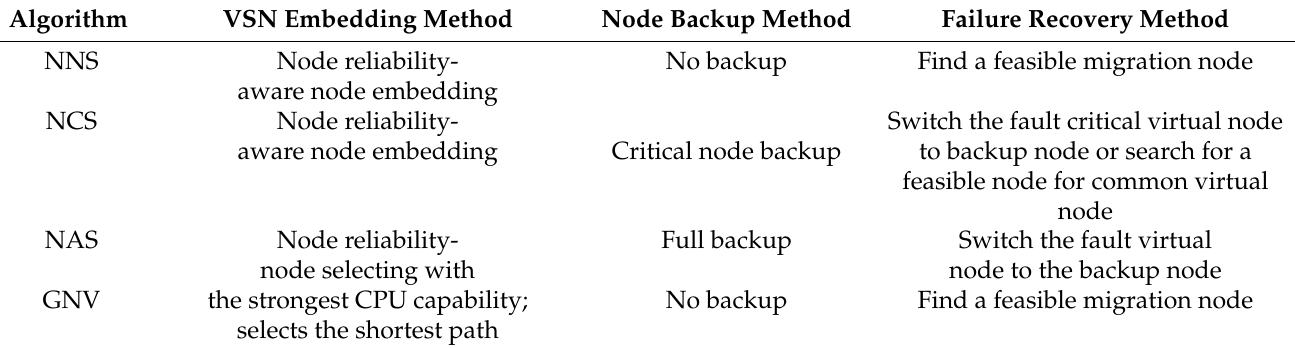
Table 2. Four embedding